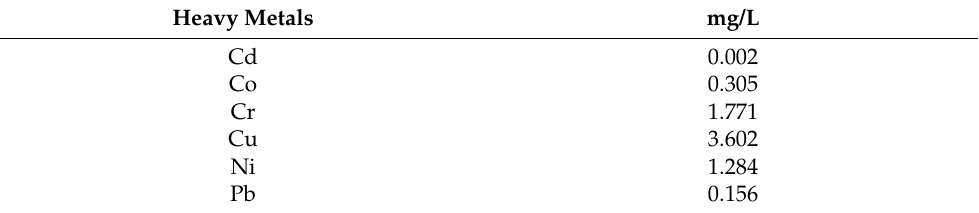
Table 2. Heavy metals in